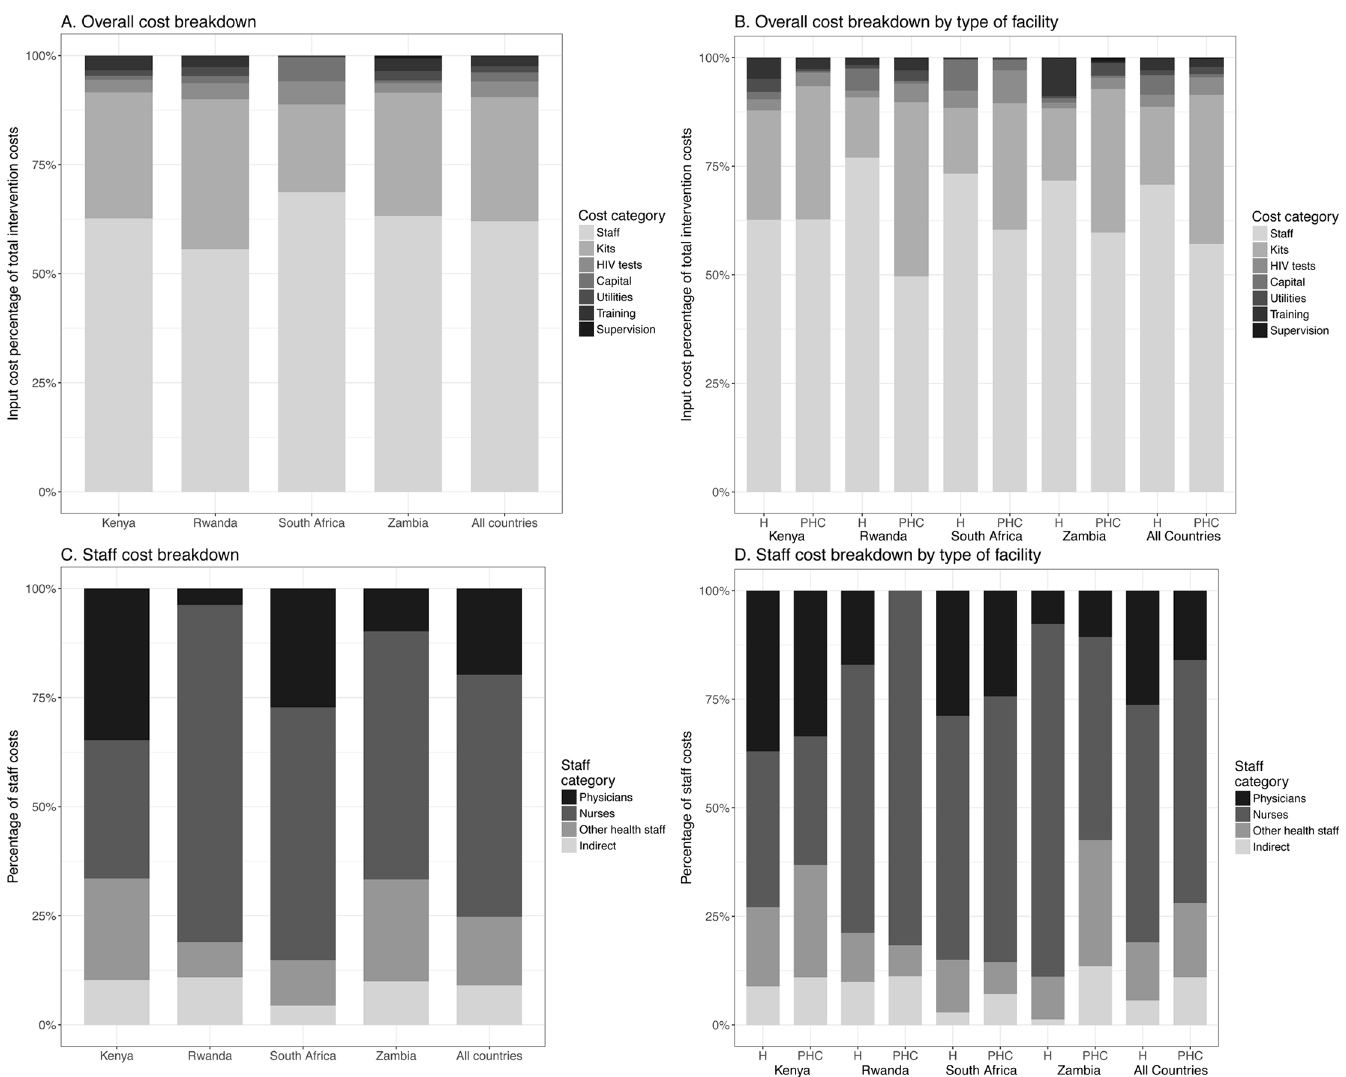
Fig 2. Overall and country-level breakdown of unit cost by cost category and breakdown of staff costs by type of staff. H = hospital, PHC = primary health care facilities. General and specialized nurses were included in nurses category.